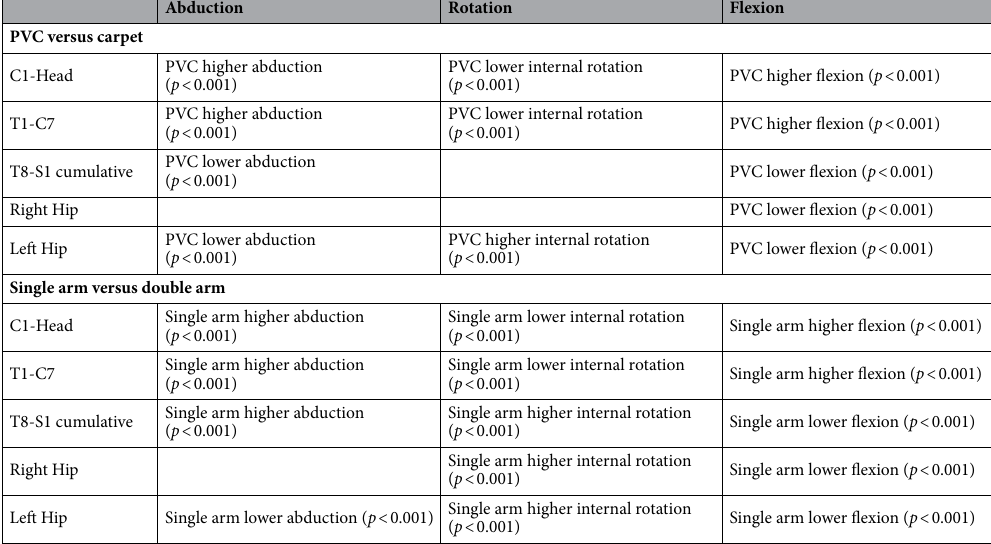
Table 3. A high level summery of the significant differences between the two floor conditions and the two grip positions. In general, the difference between the floor condition is in the order of 2° to 3° while the difference between the holding position is between 5° and 10°.